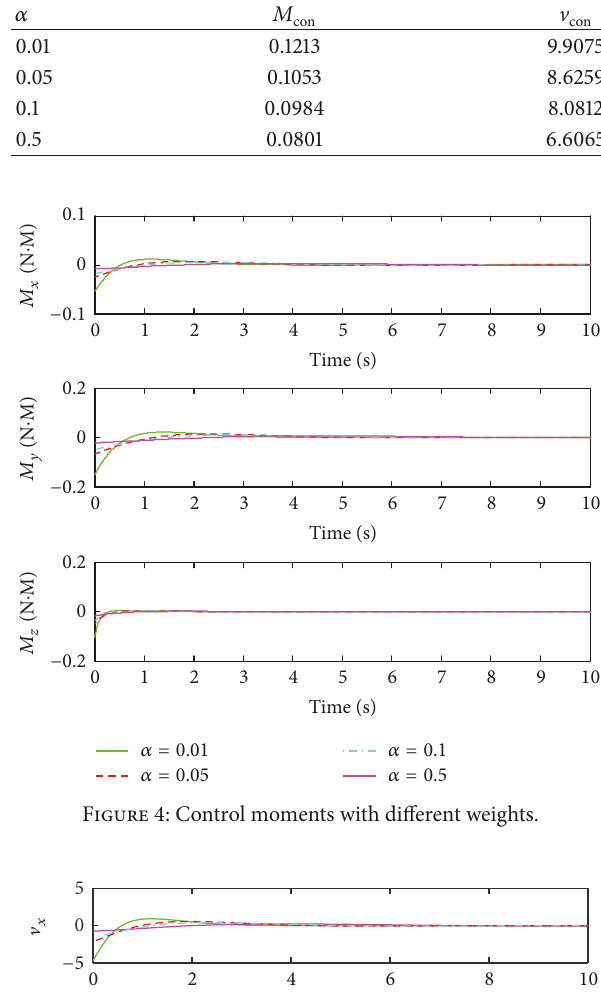
Table 2: Control energy consumption with different weights.